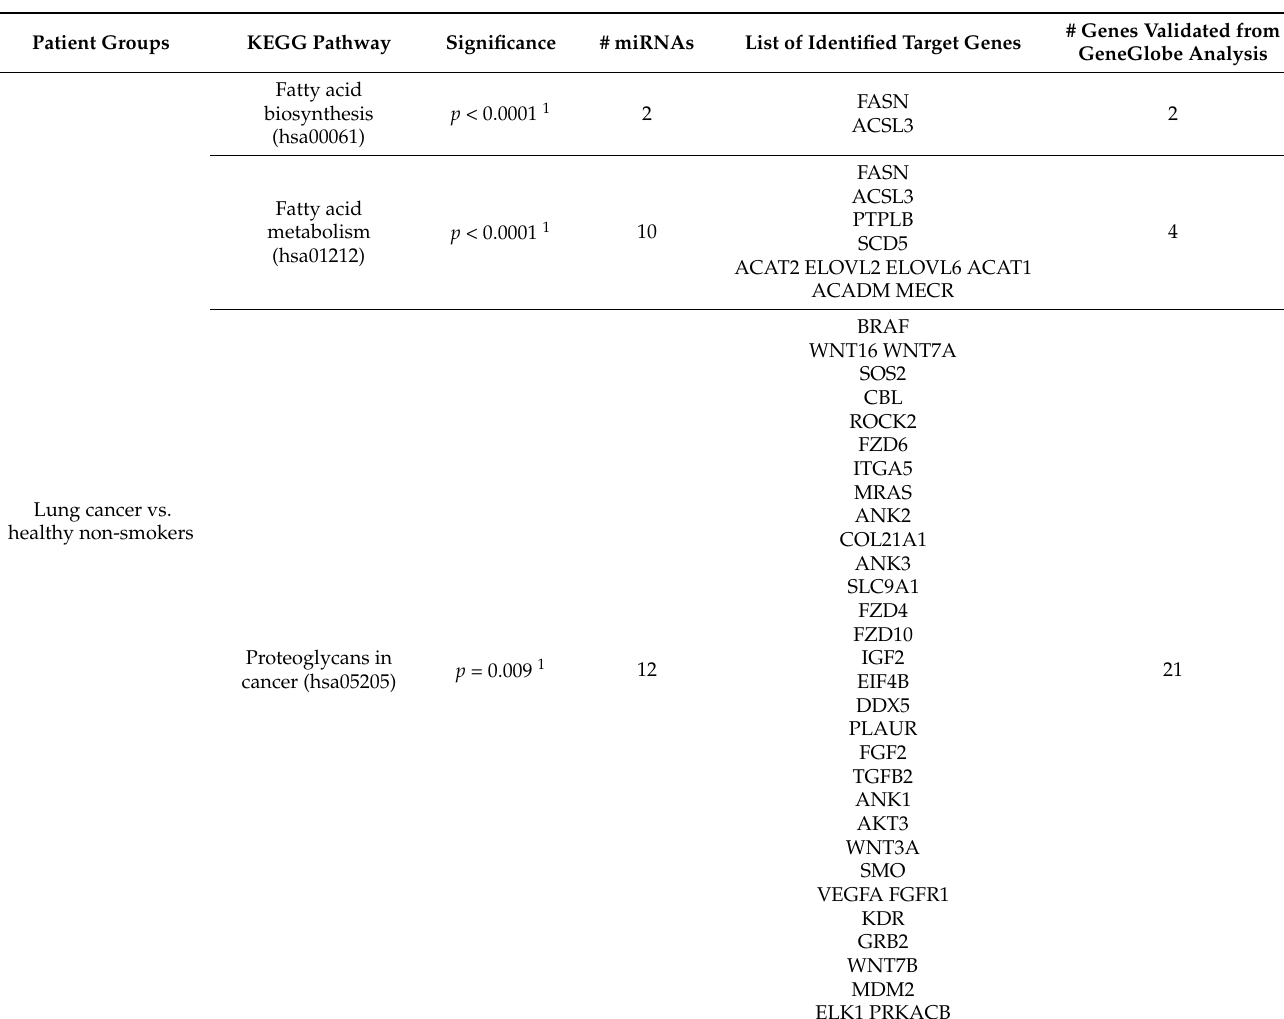
Table 3. Predicted biological pathways enriched by the significantly dysregulated miRNAs as identified in the primary analyses of lung cancer participants compared to healthy non-smoking